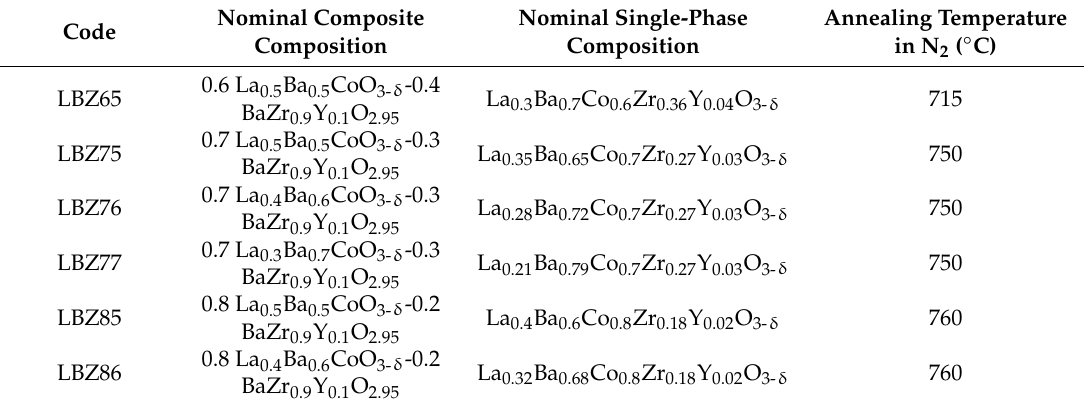
Table 1. Nominal composition, nomenclature and annealing temperature in N 2 of the single-phase material of the LBZ ( a La 1-x Ba x CoO 3- δ -(1- a ) BaZr 0.9 Y 0.1 O 2.95 ( a = 0.6, 0.7, 0.8 and x = 0.5, 0.6, 0.7))